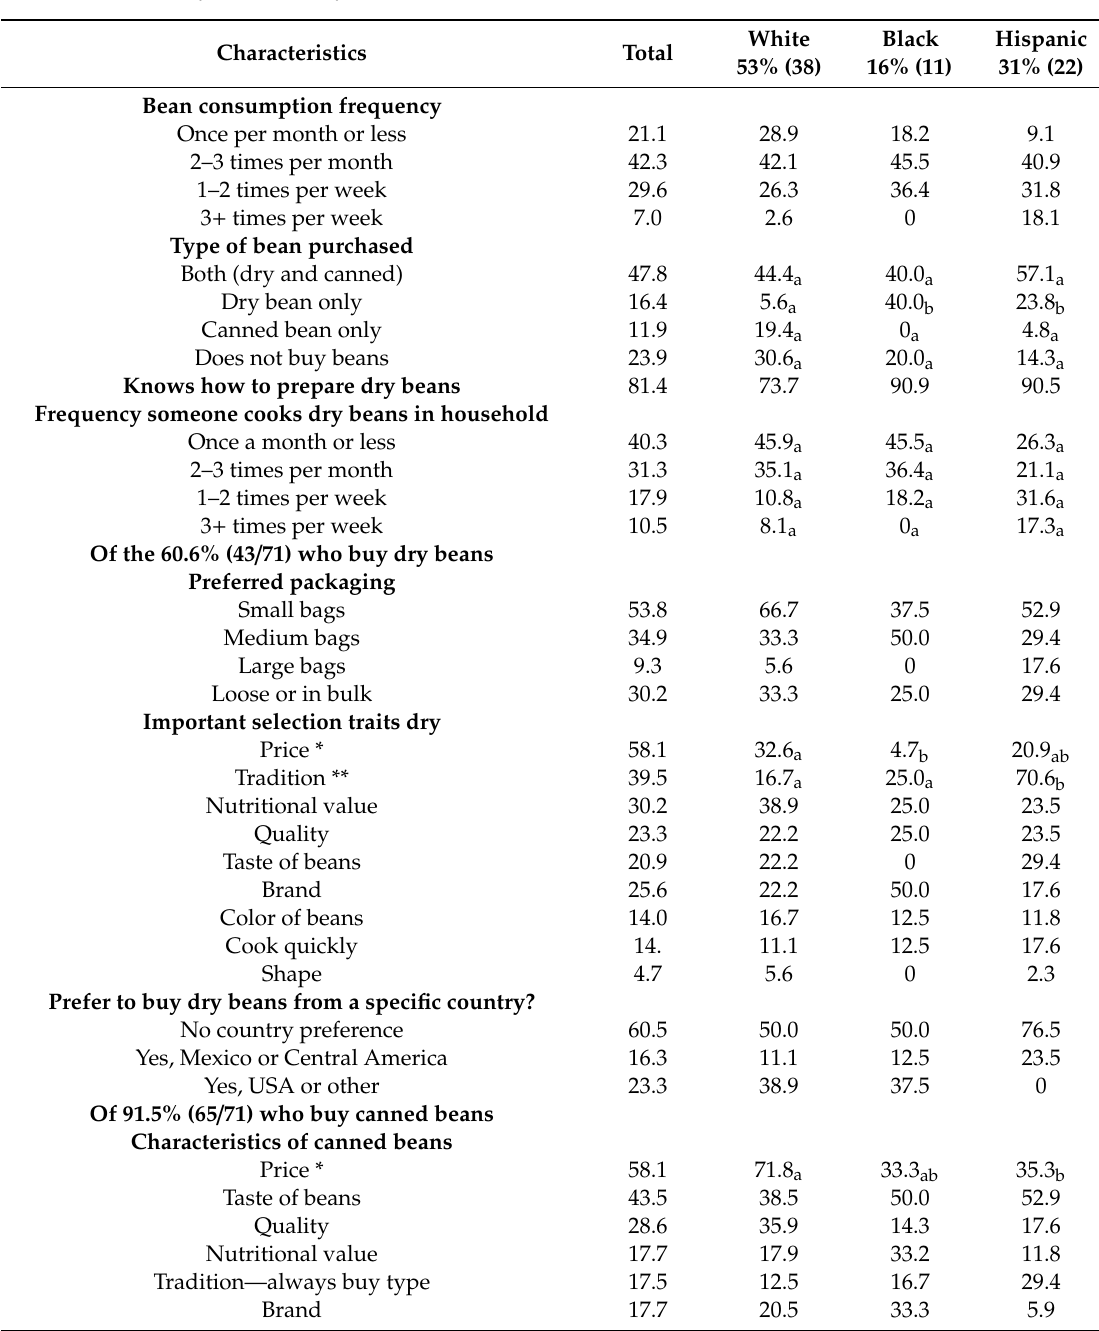
Table 5. Bean consumption frequencies, purchasing practices, and preferred characteristics of low-income Arizona men by race / ethnicity (%; N = 71).